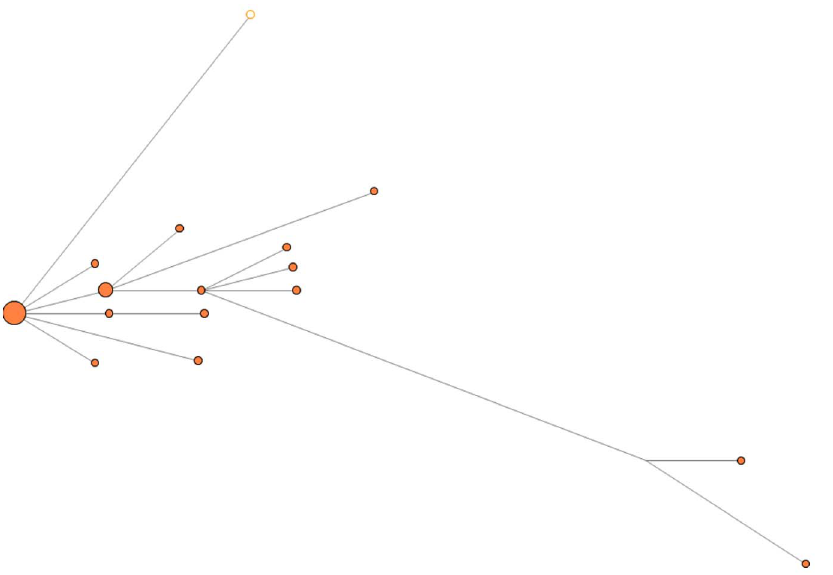
Figure 5. Genetic relationship between HAV strains associated with outbreak D. Median joining network analysis was performed using strains from outbreaks D. Color code is as in Figures 1 and 4. Non-outbreak strain sharing the same VP1/P2B sequences (open circle) is also depicted.